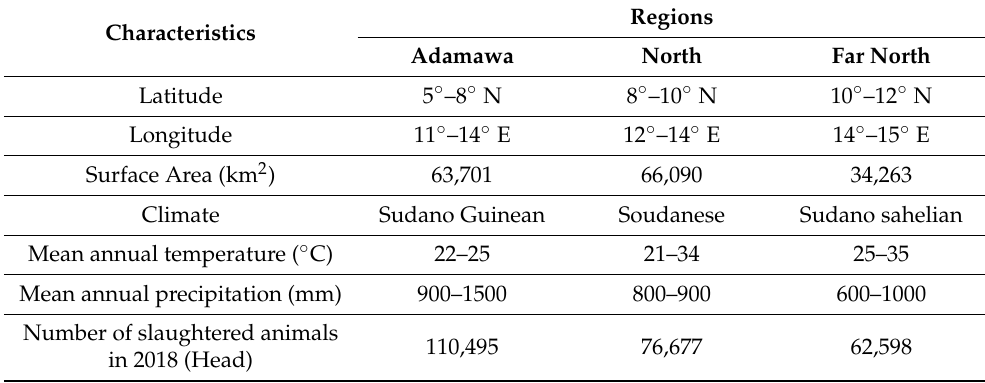
Table 1. Study area characteristics